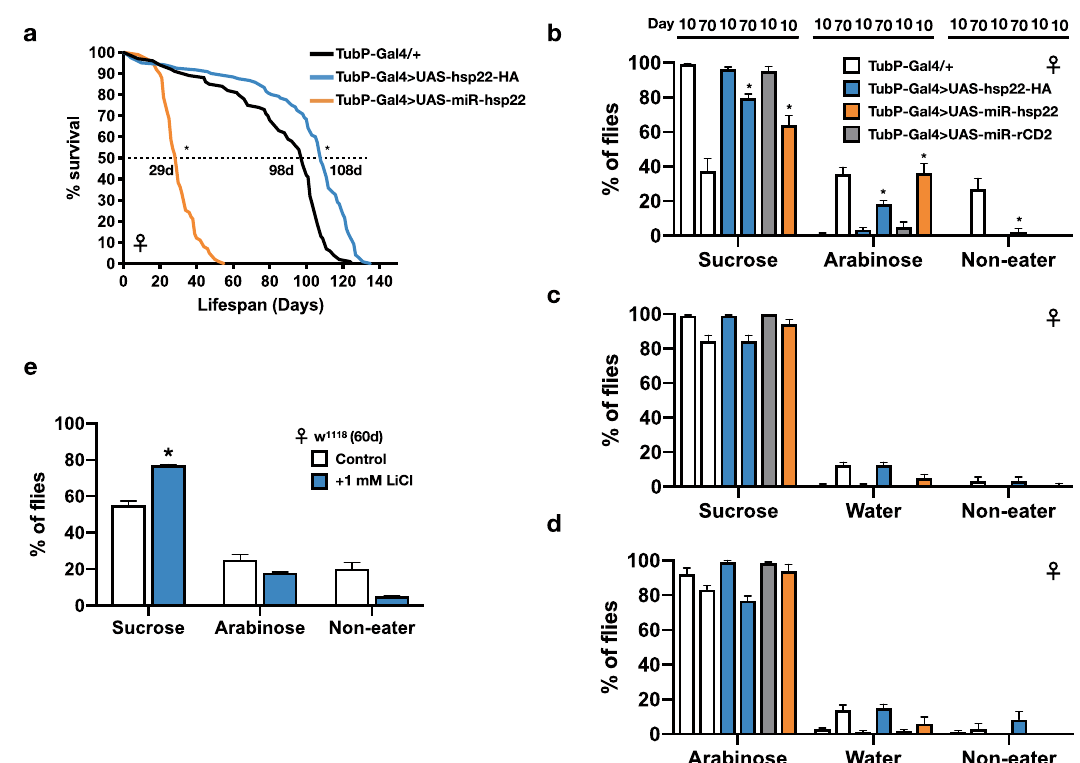
Fig. 2 Aged long-lived fl ies still maintain the proper VBFD. a Survival curves of Hsp22 over-expressing (OE; UAS-hsp22-HA) and knockdown (KD; UAS-miR-hsp22) fl ies. Results were analyzed by the log-rank test. n = 100 for each genotype. * p < 0.01. b – d VBFD assays were performed in female fl ies with altered life expectancy mediated by up- or down-regulating the expression of Drosophila Hsp22. Flies of two chronological ages were used: 10 and 70 days. The food choices used were 150 mM sucrose and 150 mM arabinose in ( b ); 150 mM sucrose and plain water in ( c ); and 150 mM arabinose and plain water in ( d ). Results were expressed as means ± SEM and analyzed by two-way ANOVA. n = 100 for each condition. * p < 0.01. The statistical signi fi cance was assessed by the comparison to age-matched controls. e Female w 1118 fl ies fed with 1 mM LiCl for 60 days were given the choices between 150 mM sucrose and 150 mM arabinose in the VBFD assay. Results were expressed as means ± SEM and analyzed by two-way ANOVA. The statistical signi fi cance was assessed by the comparison to age-matched controls. * p < 0.01. n = 100 for w 1118 w/o LiCl and n = 40 for w 1118 w/ LiCl. Note that the column of w 1118 w/o LiCl treatment was the same as presented in Fig. 1b. Genotypes: control (TubP-Gal4/ + and UAS-miR-rCD2/ + ; TubP-GAL4/ + ); OE (UAS-hsp22-HA/ + ; TubP-Gal4/ + ); KD (UAS-miR-hsp22/ + ; TubP- Gal4/ + ). All fl ies used in above assays were maintained at 25